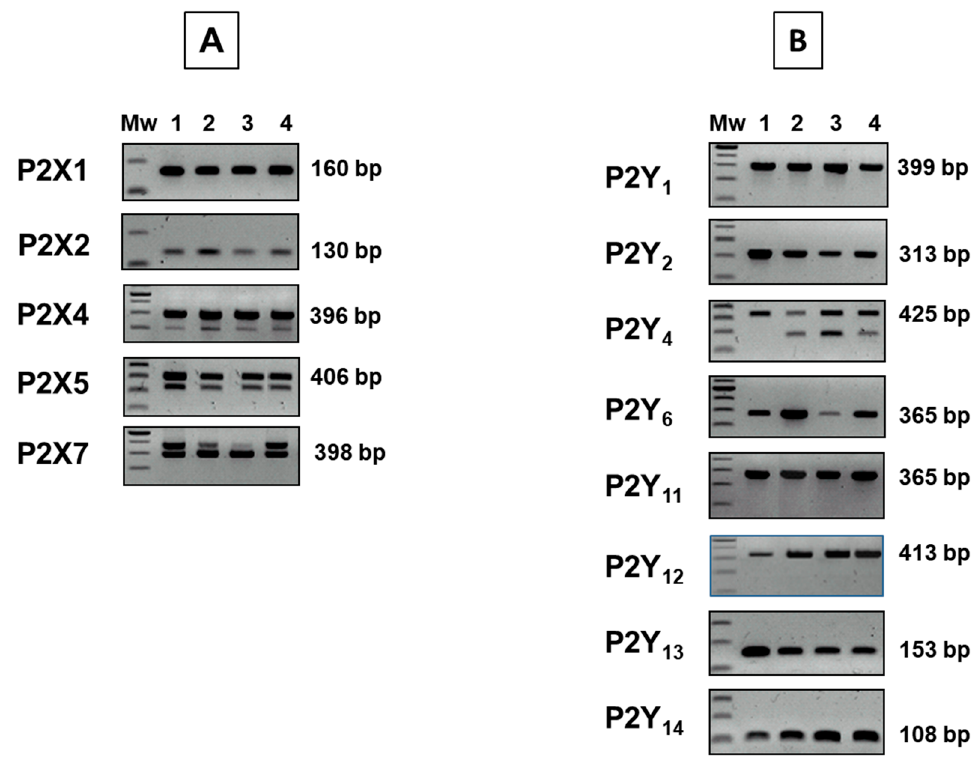
Figure 1. P2X ( A ) and P2Y ( B ) purinergic receptor subtype mRNA expression in human adipose tissue. Mw: marker weight; lane 1: positive control; lane 2: in vitro differentiated mature adipocytes; lane 3: subcutaneous adipose tissue; lane 4: visceral adipose tissue.